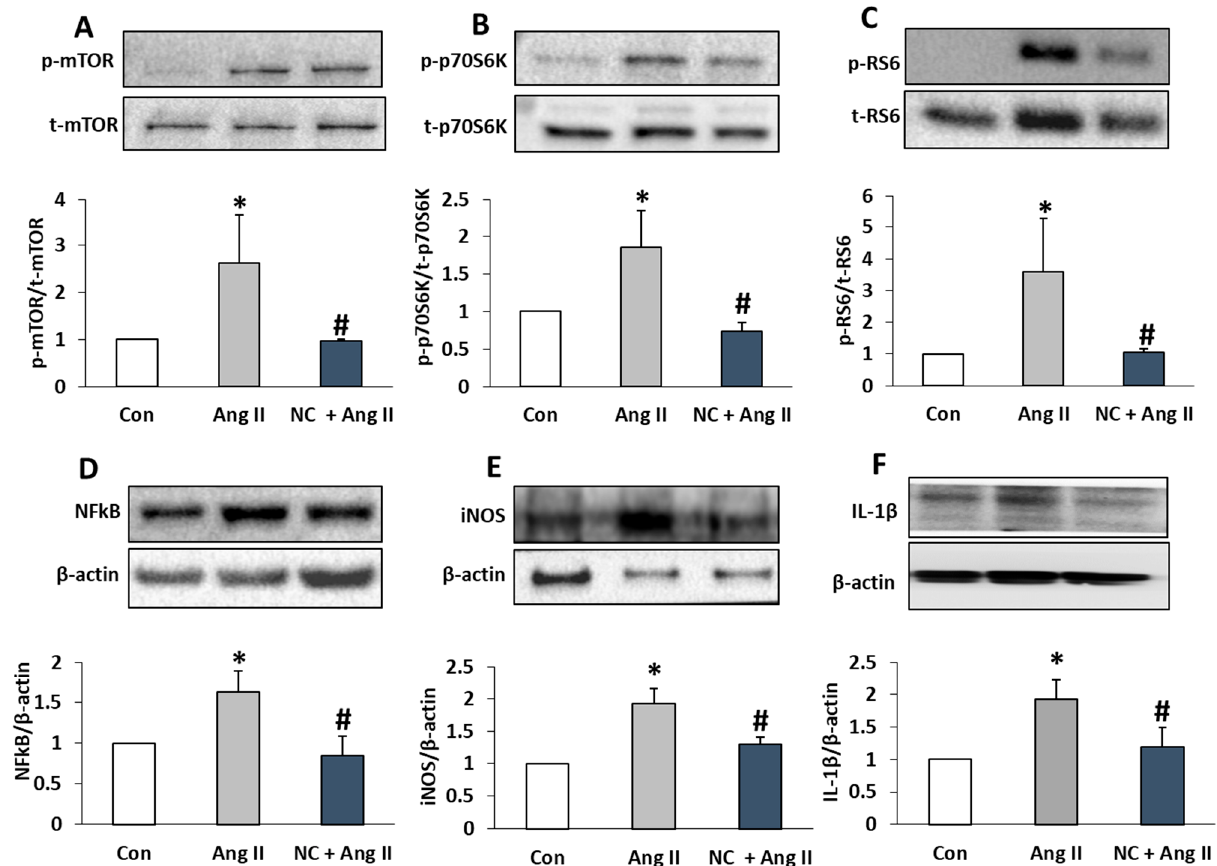
Figure 4. NC inhibited the phosphorylation of the mammalian target of rapamycin complex 1 (mTORC1) cascade and proinflammatory proteins in H9c2 cells. Top: Immunoblots represent phos- pho/total levels of mTOR ( A ), p70S6K ( B ), and RS6 ( C ) in H9c2 cells treated with Ang II (1 µ M) and NC (10 µ g/mL) plus Ang II (1 µ M). Bottom: Bar graphs represent densitometry analysis of the intensity of the phosphorylated protein bands after adjusting for the intensity of total protein bands. Immunoblots represent protein expression of NFkB ( D ), iNOS ( E ), and IL-1 β ( F ) in H9c2 cells treated with Ang II and NC plus Ang II. Bottom: The intensity of the target protein band was normalized to β -actin bands, and densitometry analyses are presented as bar graphs. * p < 0.05 vs. Con and # p < 0.05 vs. Ang II.